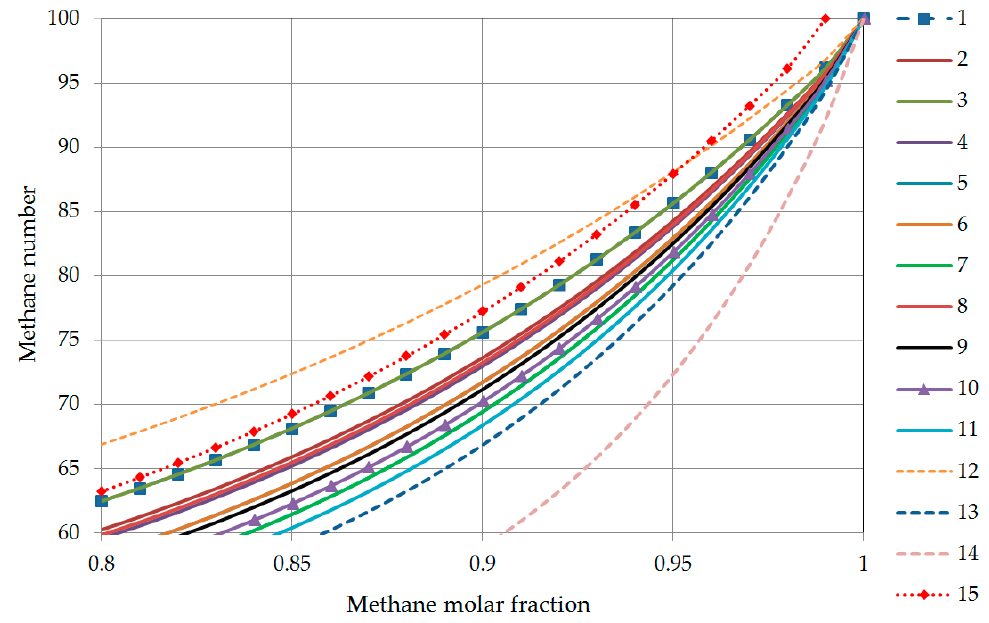
Figure 2. Methane number as function of methane molar fraction in analyzed LNG composition sets .